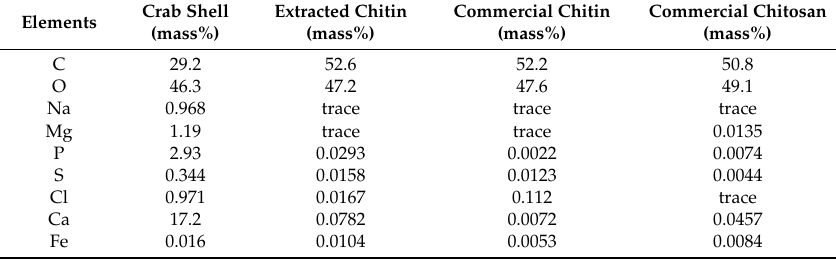
Table 2. Elemental composition of crab shell, extracted chitin, commercial chitin, and commercial chitosan analyzed by X-ray fluorescence spectroscopy